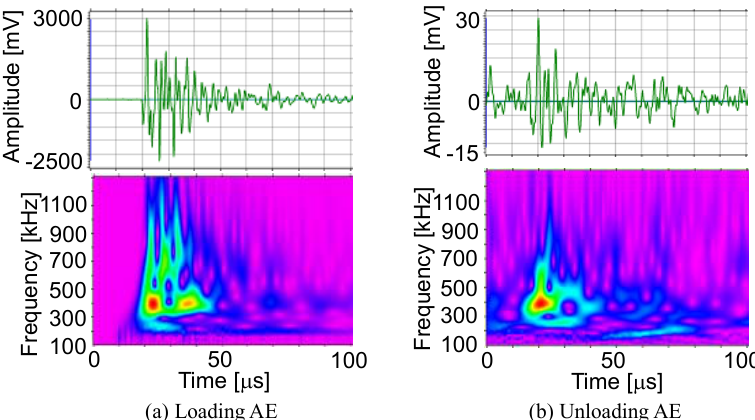
Fig. 10. Typical waveforms and wavelet patterns of loading and unloading